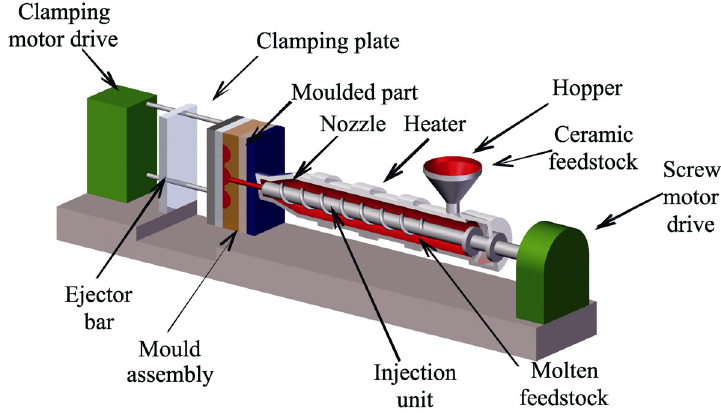
Fig. 17 Schematic diagram of the micro-injection moulding